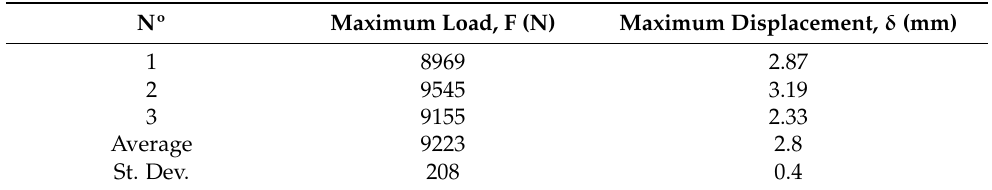
Table 4. Maximum load and displacement at failure for control specimens (not immersed), adapted from [60,62,63].